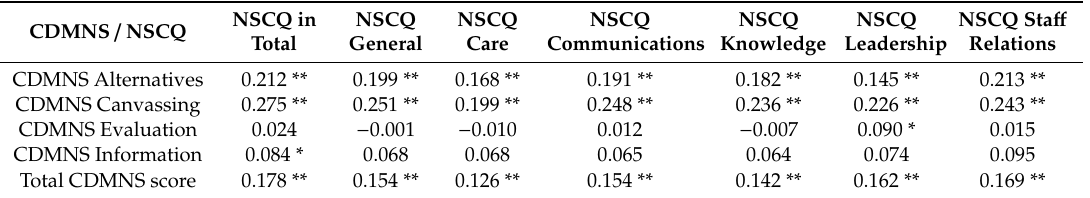
Table 4. Correlation between nurses’ self-concept (NSC) and clinical decision-making (CDM) in nurses ( n = 568).